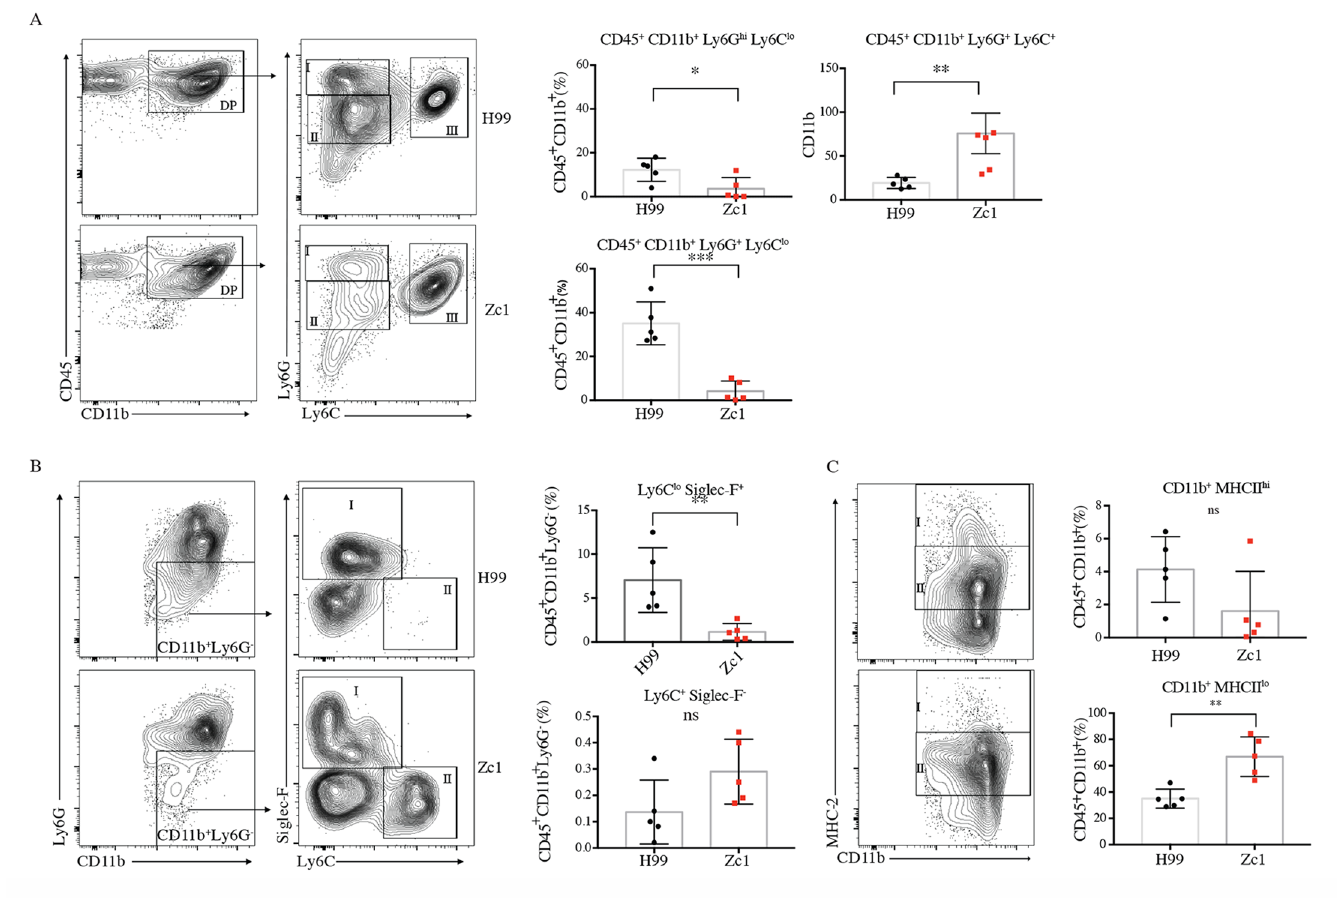
Fig 8. Zc1 and H99 infections differentially impact host immune response. FACS analyses for immune cell recruitment to the lungs for mice infected with H99 or Zc1 (day 7 p.i., n = 5 per group). A) Concatenated analysis for 5 mice under each condition were gated for CD45 + CD11b + populations and then analysed for Ly6G and Ly6C markers. Indicated populations of CD45 + CD11b + cells in individual mice were analysed for the two conditions ( (cid:3) p = 0.0299; (cid:3)(cid:3) p = 0.0079; (cid:3)(cid:3)(cid:3) p < 0.0002). B) Indicated populations of CD45 + CD11b + Ly6G- cells in individual mice were further analysed for SigLecF and Ly6C markers ( (cid:3)(cid:3) p = 0.0085). C) Indicated populations of CD45 + CD11b + cells in individual mice were further analysed for MHCII markers ( (cid:3)(cid:3) p = 0.0027).